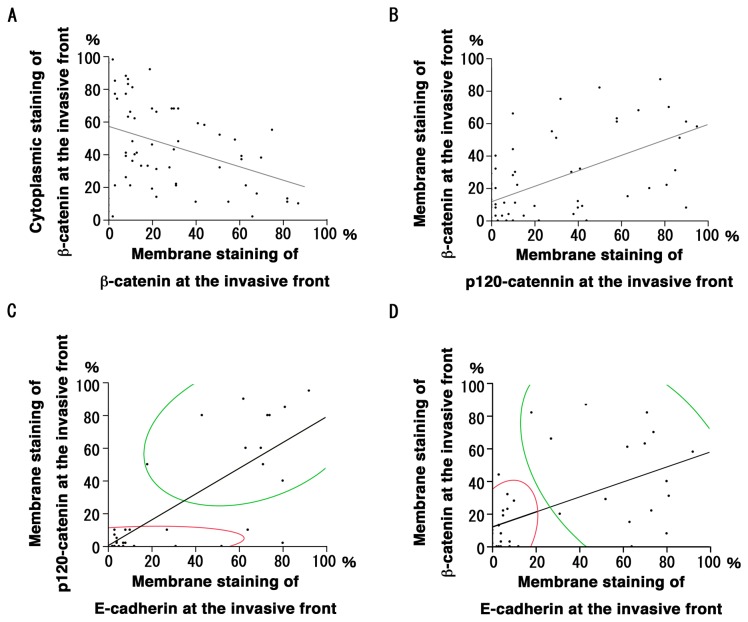
Correlation of percentage of catenin- and E-cadherin-positive carcinoma cells.A: The percentage of β-catenin-membrane-positive and –cytoplasm-positive at the invasive front were inversely correlated (P < 0.01, R2 = 0.11). B: The positive correlation of the percentage of membrane-positive carcinoma cells for p120-catenin and β-catenin at the invasive front (P < 0.01, R2 = 0.33). C: The percentage of membrane-positive carcinoma cells for p120-catenin and E-cadherin at the invasive front showed the positive correlation (P < 0.01, R2 = 0.60). Cluster analysis grouped carcinomas into p120high/E-cadherinhigh (green) and p120low/E-cadherinlow (red) fractions. D: The positive correlation between the percentage of membrane-positive carcinoma cells for β-catenin and E-cadherin at the invasive front (P < 0.01, R2 = 0.29) was observed. Carcinoma cells were categorized into β-cateninhigh/E-cadherinhigh (green) and β-cateninlow/E-cadherinlow (red) fractions.